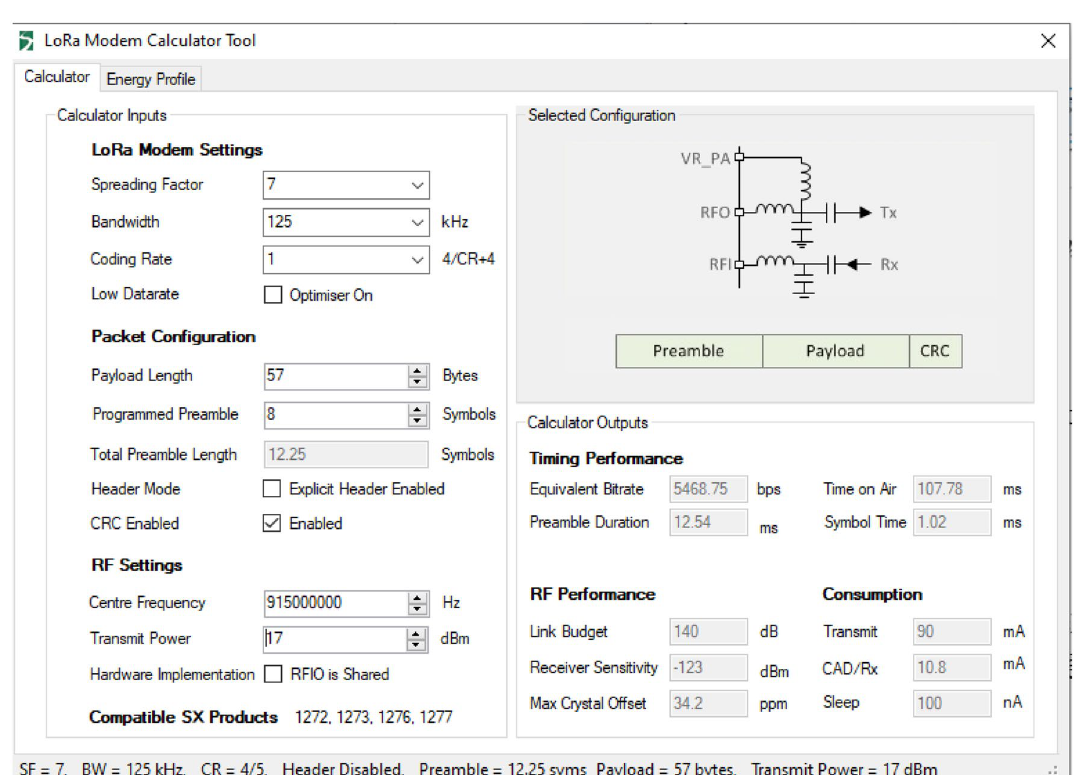
Figure 22. Calculation of ToA in the LoRa Modem Calculator Tool 48